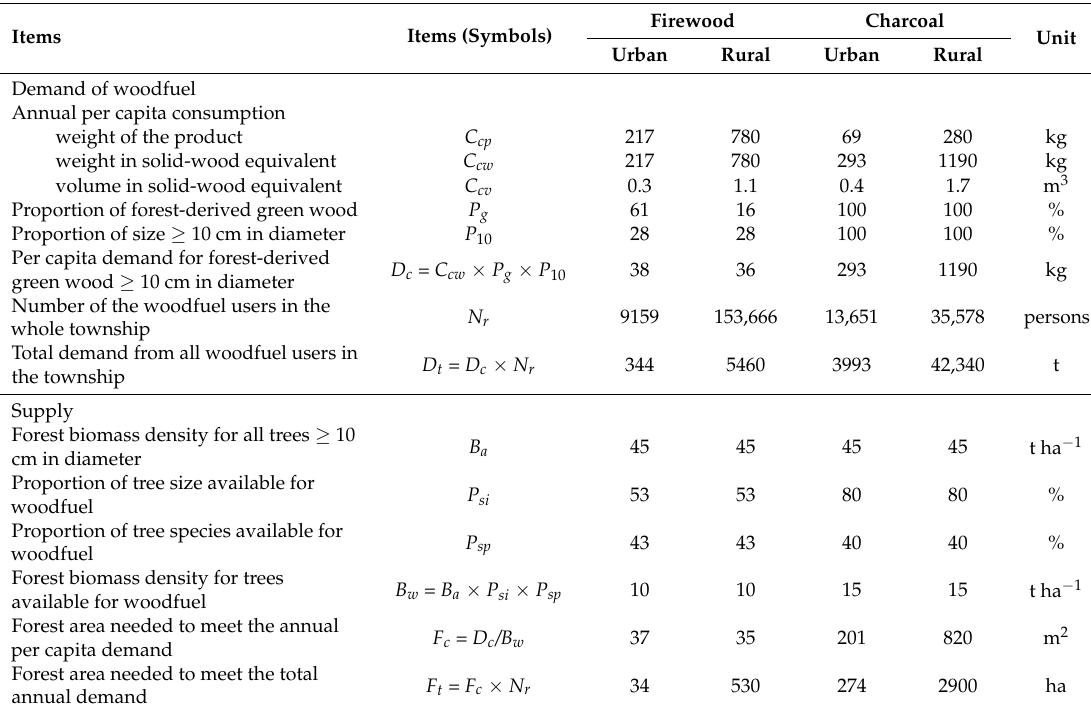
Table 3. Summary of woodfuel supply and demand in urban and rural areas; values for the rural area are from Win et al. [18].